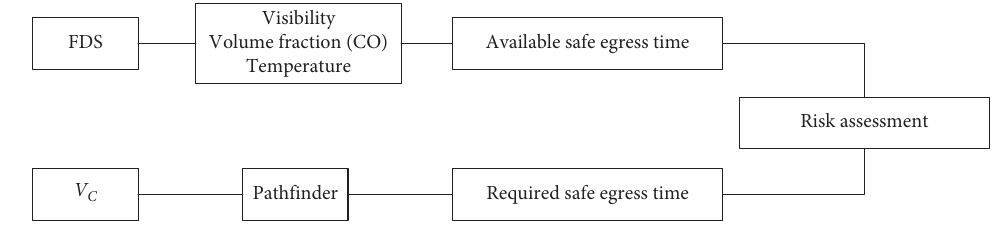
Figure 1: Traditional